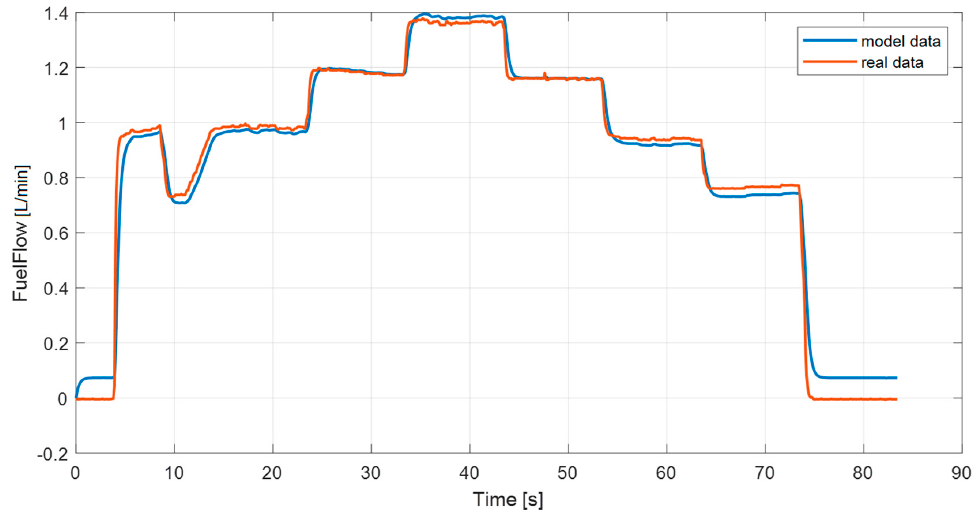
Figure 5. Comparison of the data measured on a fuel test bench and data from the dynamic model.